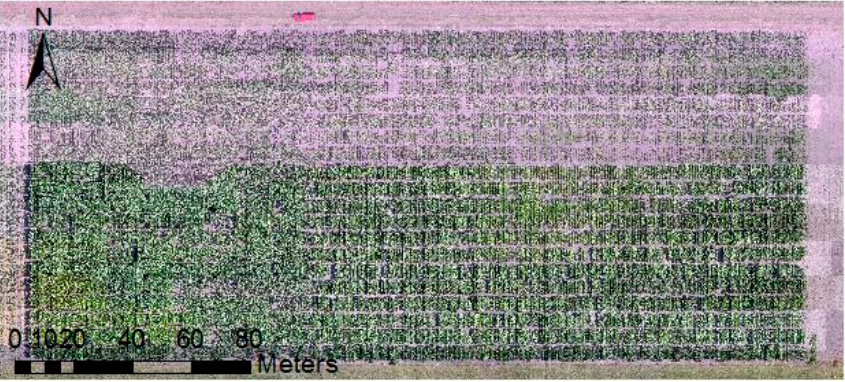
Figure 10. RGB-based orthophoto of the test field derived from the captured frame images on 25 July 2015.